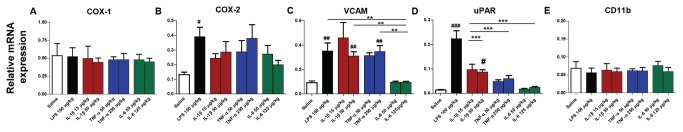
Impact of systemic LPS, IL-1β, TNF-α and IL-6 challenge on cyclooxygenases and cell markers.Hippocampal transcription of the biosynthetic enzymes COX-1, COX-2, VCAM, uPAR and CD11b mRNA measured using quantitative PCR in C57BL/6 female mice 2 hours after systemic challenge (i.p.) with saline, LPS (100 µg/kg), IL-1β (15 µg/kg or 50 µg/kg), TNF-α (50 µg/kg or 250 µg/kg) and IL-6 (50 µg/kg or 125 µg/kg). All data groups were compared by one-way ANOVA, followed by Bonferroni post-hoc tests comparing differences between saline, LPS and each cytokine treatment at the higher dose. # denotes treatment is significantly different to saline treatment p<0.05, # # p<0.01, # # # p<0.001. *** denotes significant difference between treatment groups indicated by line p < 0.001. All data have been presented as mean±SEM, n=5 for all groups except n=4 for TNF-α 250 µg/kg; n≥3 for IL-1β 15 µg/kg and both IL-6 groups.